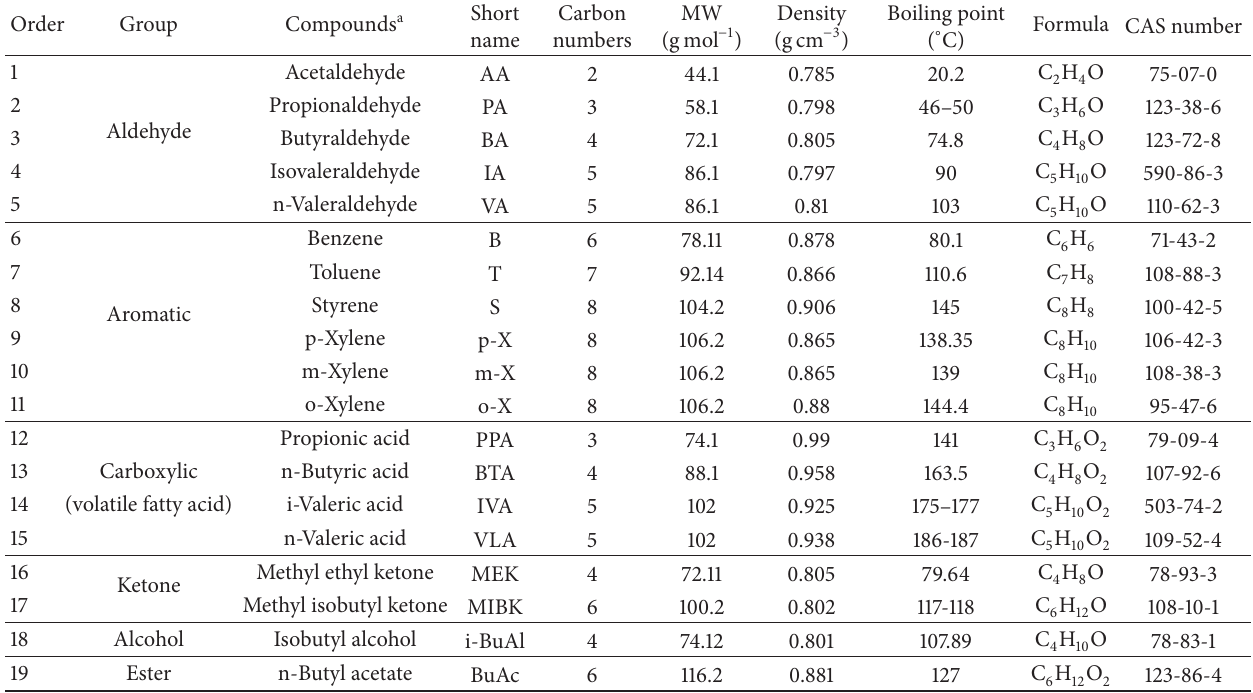
Table 2: List of 19 VOCs investigated in this study for the derivation of predictive equations for